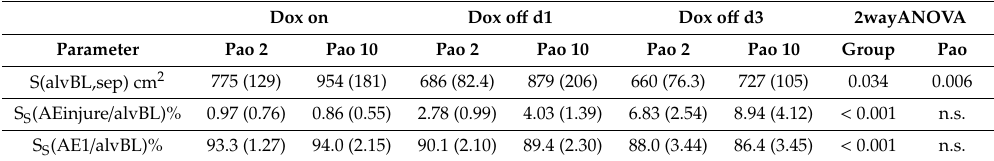
Figure 6. Injury of alveolar epithelial cells. Normal alveolar epithelial cells can be found in Dox on ( A ) and ( B ). In Dox off d1, swelling and clearance of cytoplasmic ground substance (asterisk) and ruptures in alveolar epithelial cell lining (arrowhead) could be found ( C ) and ( D ). In Dox off d3, similar observations as in Dox off d1 were present ( E ) and ( F ). Abbreviations: AE1: alveolar epithelial type 1 cell; endo: endothelial cell; caplumen: lumen of septal wall capillary; bl: basal lamina (junction of alvBL and endoBL); alvBL: alveolar epithelial basal lamina; endoBL: endothelial basal lamina; IC: interstitial cell; aPM: apical plasma membrane; air: alveolar airspace; fluid: alveolar fluid. Arrowhead: rupture of alveolar epithelial cell; asterisk: swollen AE1 cell.